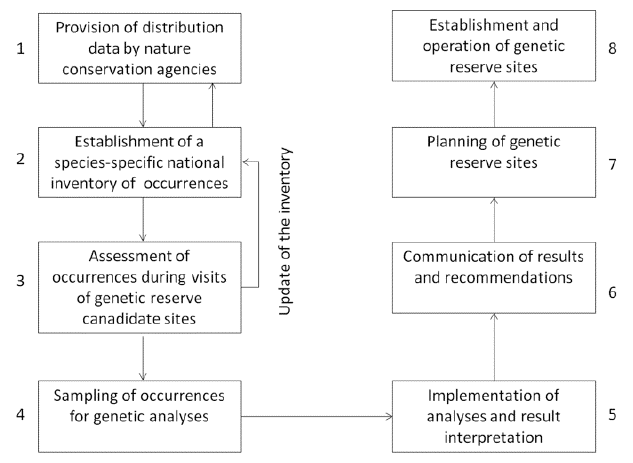
Figure 4. The flow diagram illustrates the procedure of establishing species-specific genetic networks in Germany.